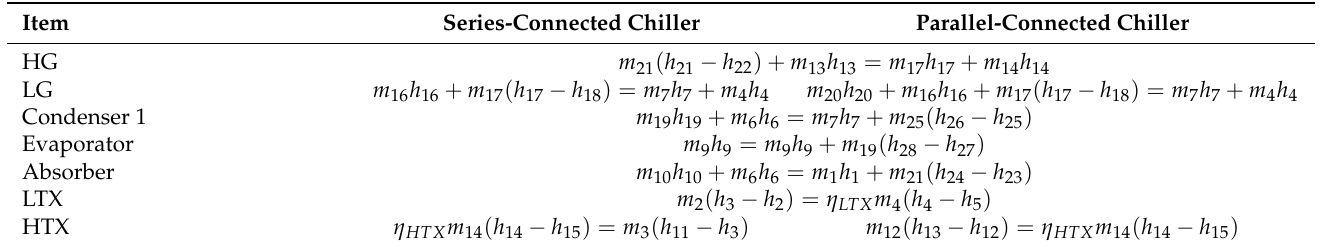
Table 1. Energy principles of components in two chiller types [33].